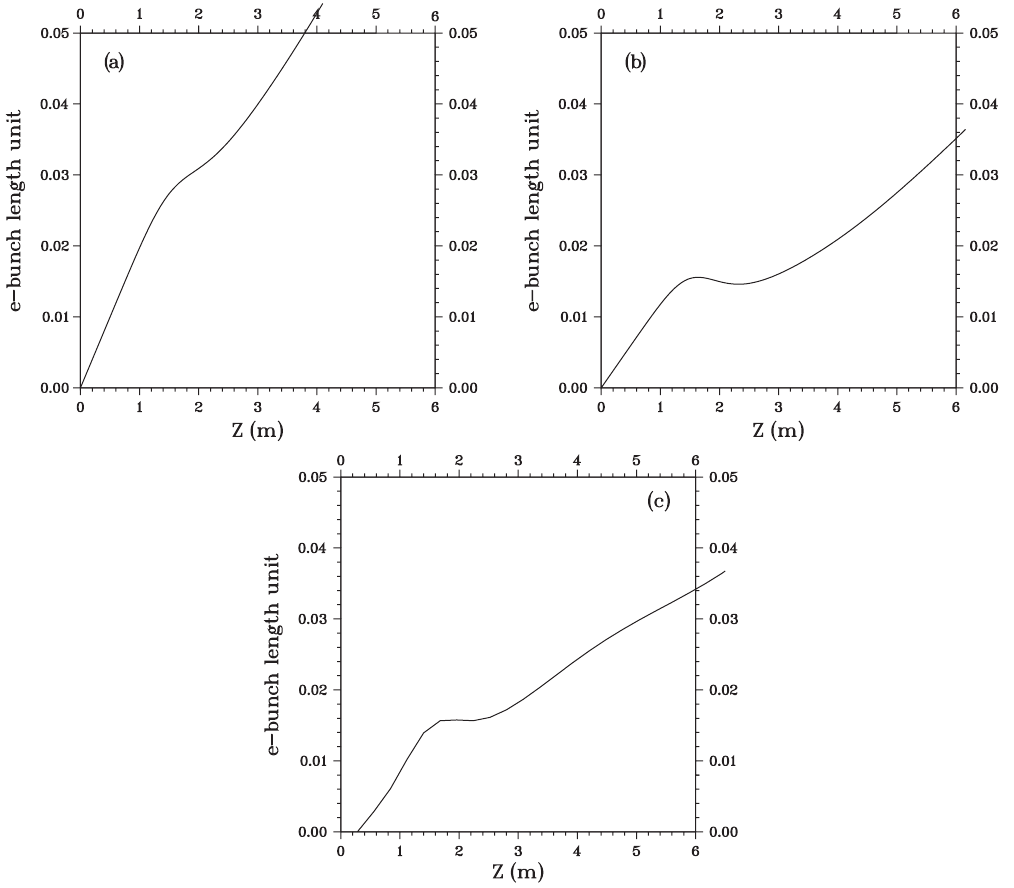
FIG. 2. Centroid position ( (cid:8) units) of the optical packet, with respect to the e-bunch, vs the undulator coordinate: (a) from (2.13), z m ¼ 1 and D ¼ (cid:1) (cid:1) ; (b) from Eq. (2.13), m ¼ 1 and D ¼ 0 : 6 (cid:6) (cid:1) (cid:1) ; (c) PROMETEO numerical simulation. Same parameters as Fig.